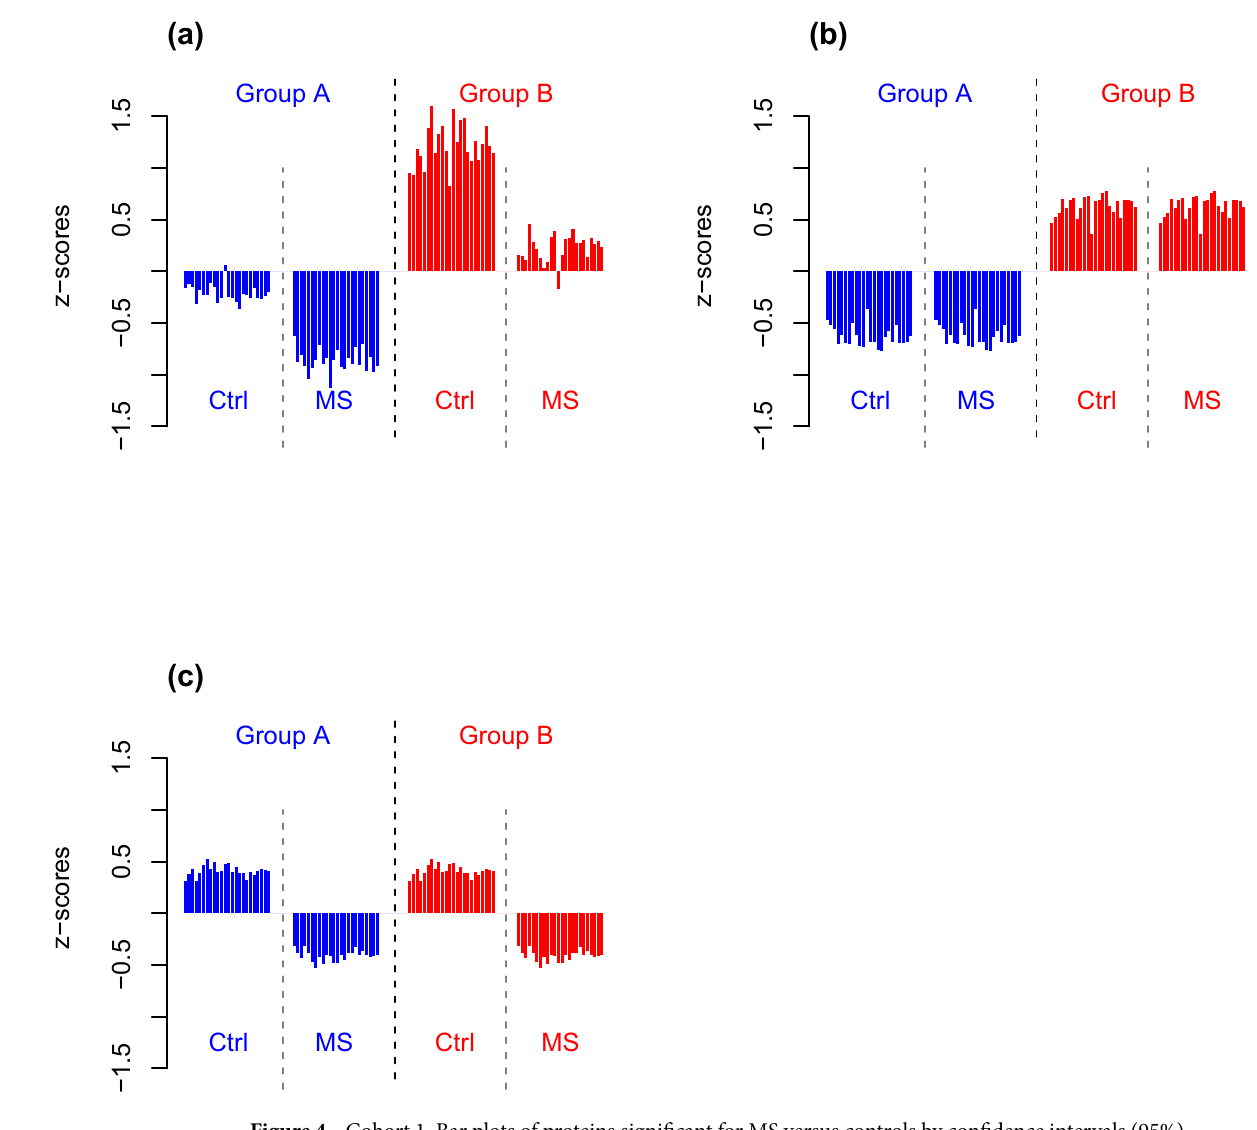
Figure 4. Cohort 1. Bar plots of proteins significant for MS versus controls by confidence intervals (95%) applied within group A and within group B. Each bar is means of one protein for each of the four categories: controls in group A (Group A, Ctrl, blue bars, n = 55), MS patients group A (Group A, MS, blue bars, n = 7), controls in group B (Group B, Ctrl, red bars, n = 9), and MS patients in group B (Group B, MS, red bars, n =